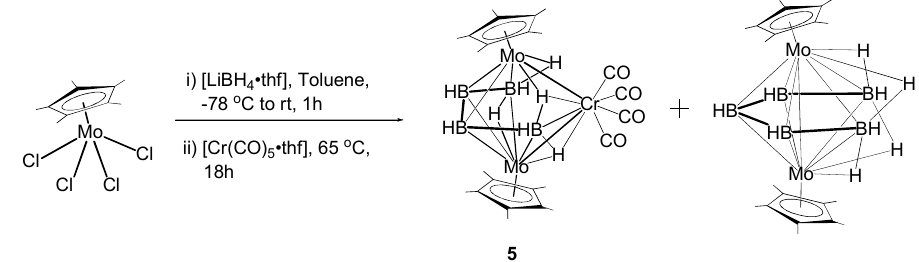
Figure 2. Molecular structure and labeling diagram of 4 . Selected bond lengths (Å) and bond angles